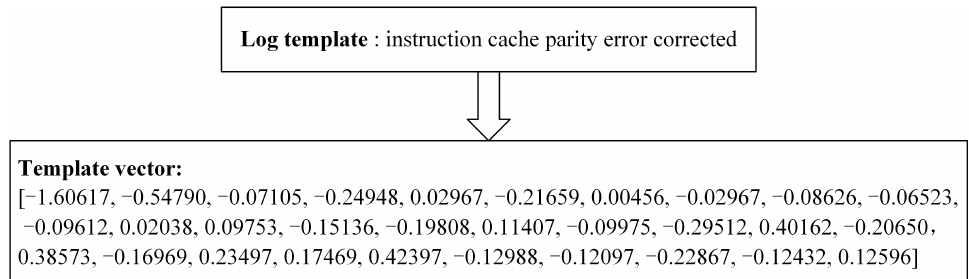
Figure 3. Example of log template